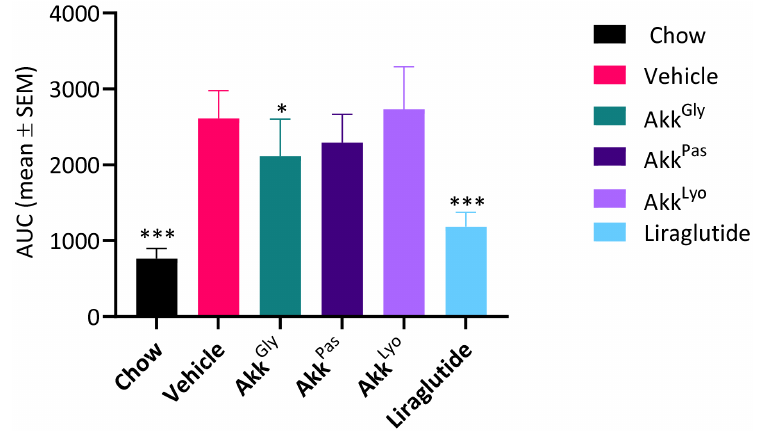
Figure 9. Akkermansia sp. DSM33459 improves HOMA-IR in a DIO mouse model ( n = 10). Serum insulin and glucose levels were measured and used for the determination of HOMA-IR. HOMA-IR of animals fed on a standard chow (Chow) or high-fat diet (HFD) and treated by oral gavage with a solution of vehicle (PBS + Glycerol) or Akkermansia sp. DSM 33459 frozen (Akk Gly ) or pasteurized (Akk Pas ) or lyophilized (Akk Lyo ) for 12 weeks. Data are presented as mean ± SEM. *, p < 0.05; ***, p < 0.001, compared to vehicle.